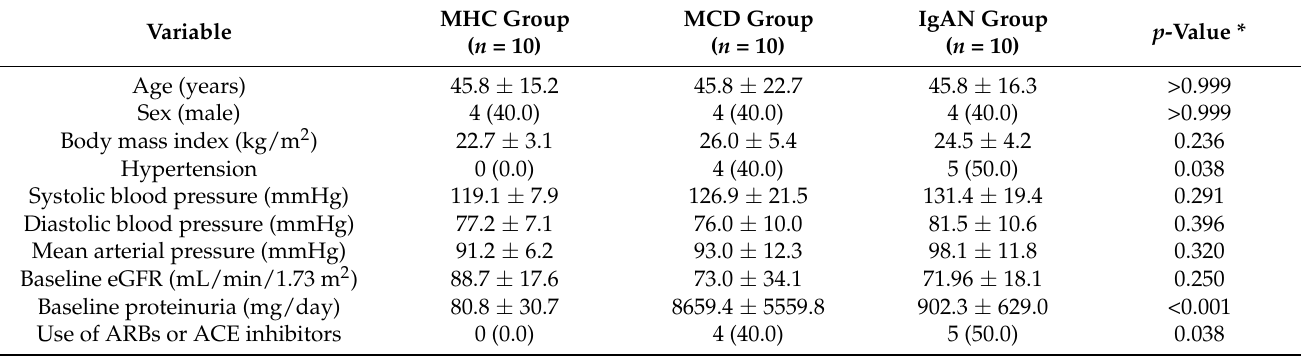
Table 1. Baseline characteristics of the MHC, MCD, and IgAN groups in the prospective study.